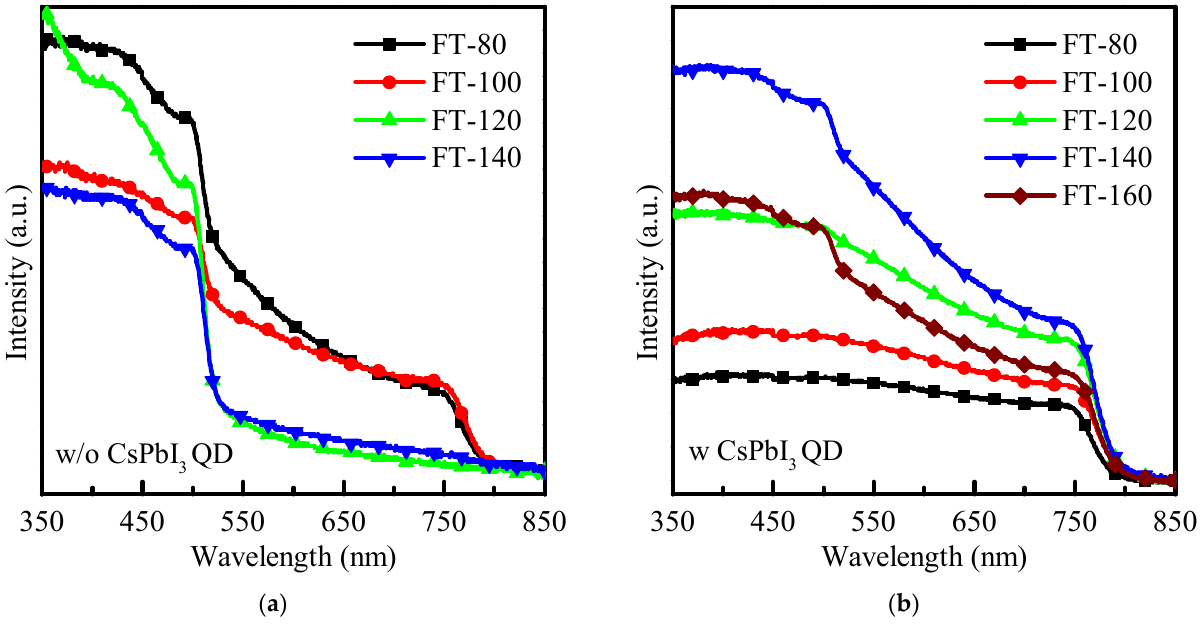
Figure 1. ( a ) Absorption spectrum of pristine MAPbI 3 . ( b ) Absorption spectrum of CsPbI 3 -QD doped MAPbI 3 under different filming temperatures (FTs) from 80 to 160 ° C.